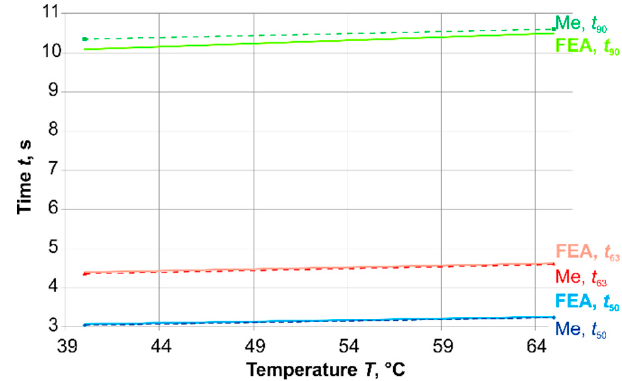
Figure 6. Comparison of FEA and experimental results (Me).